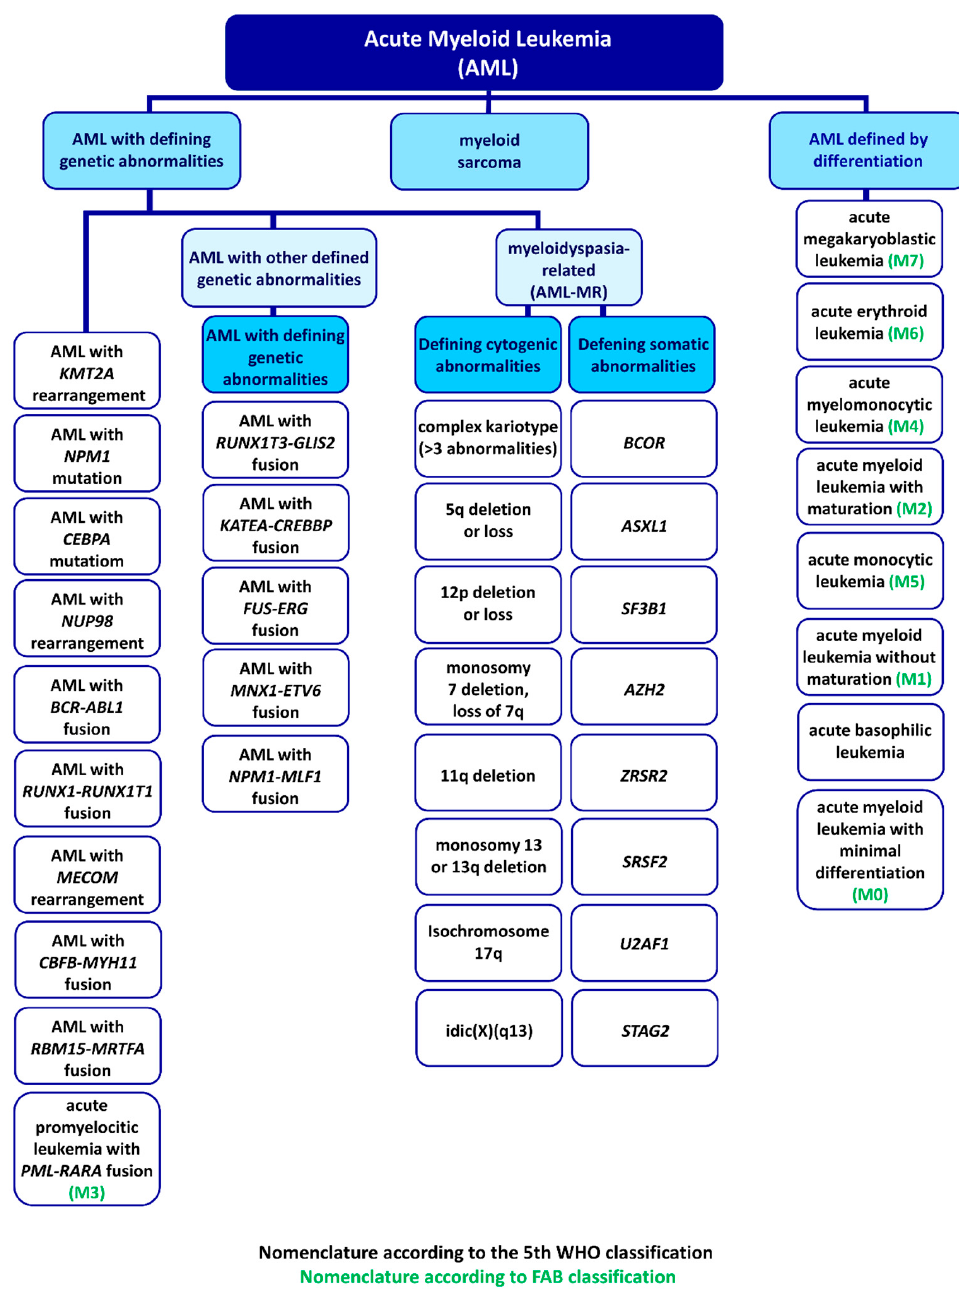
Figure 2. AML classification based on the fifth edition of the WHO classification [5].